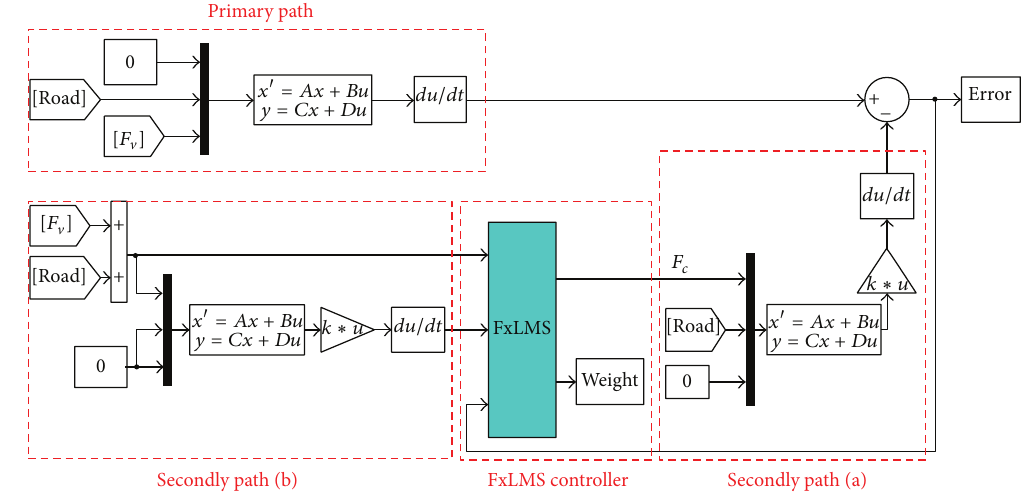
Figure 12: The Simulink model for FxLMS